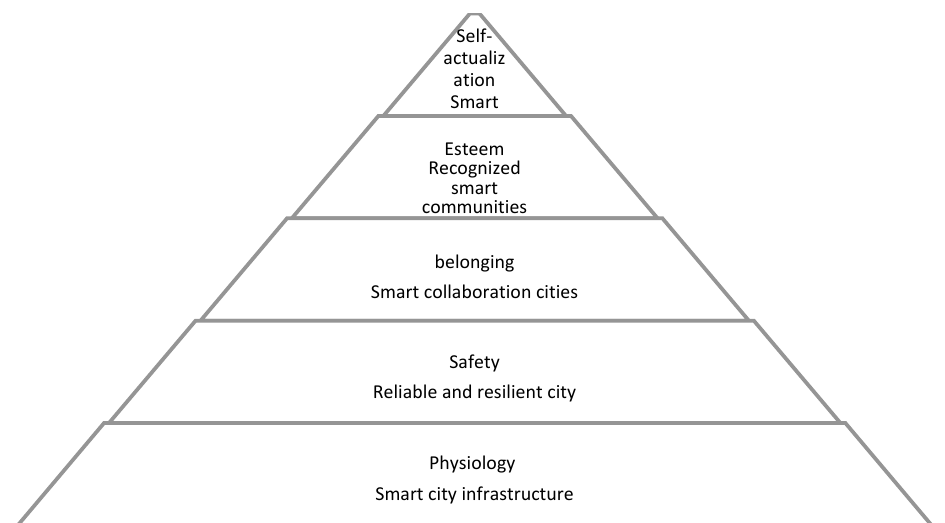
Fig. 2: Hierarchy of needs: application in smart communities (Maslow 1954; Lang1994)